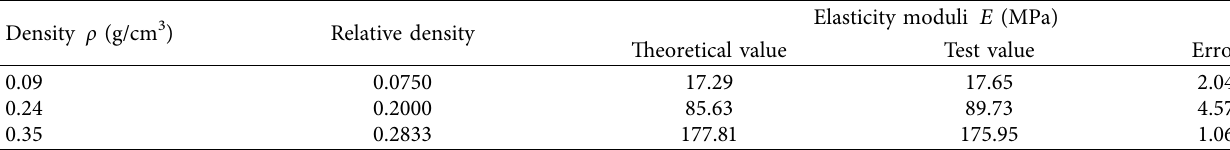
Table 4: Elasticity moduli calculation results.